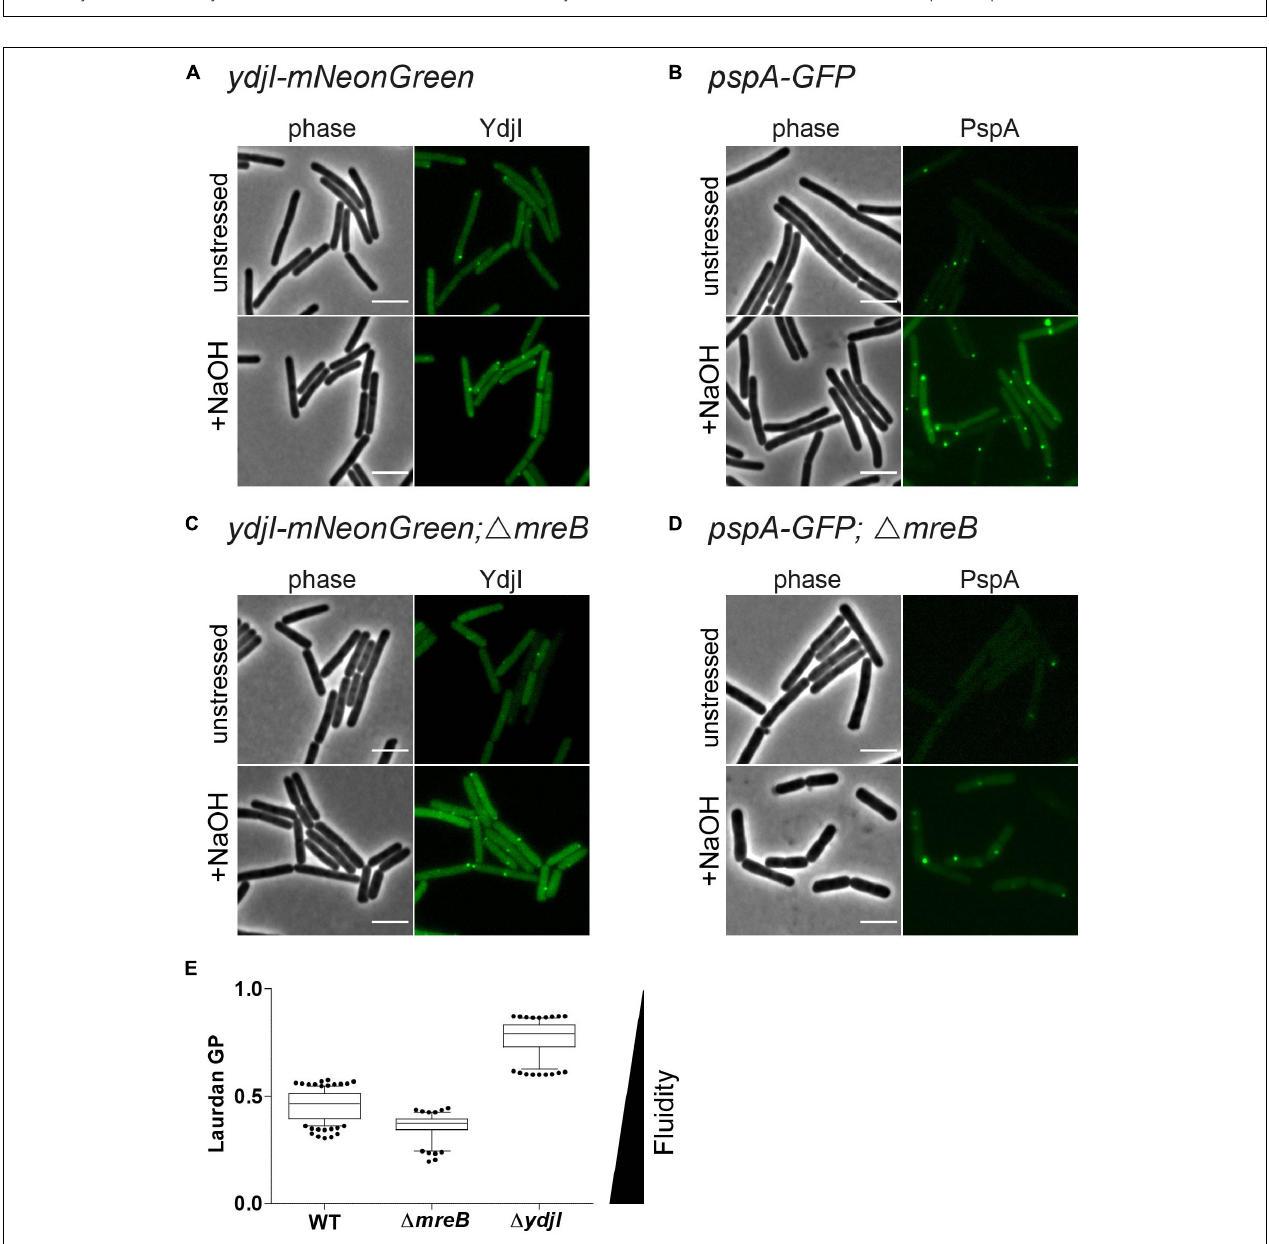
FIGURE 7 | MreB is not required for YdjI and PspA foci formation. (A) YdjI localization in unstressed and alkaline stressed conditions. (B) PspA localization in unstressed and alkaline stressed conditions. (C) YdjI localization in a mreB mutant background. Note that in stressed and unstressed conditions YdjI foci are seen. (D) Upon deletion of the cytoskeletal protein mreB , PspA still localizes in membrane associated foci. Foci numbers in strains lacking mreB are reduced (see also Table 1 ). (E) Generalized polarization analysis after Laurdan staining of WT 168, MreB, and YdjI mutant strain are shown ( n > 100); deletion of mreB causes increase in membrane fluidity, whereas YdjI deletion increases membrane rigidity. Scale bars 4 µ